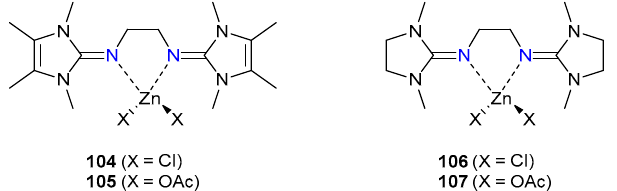
Figure 18. Zn complexes bearing imidalozin-2-imine and guanidine-based ligands [72].